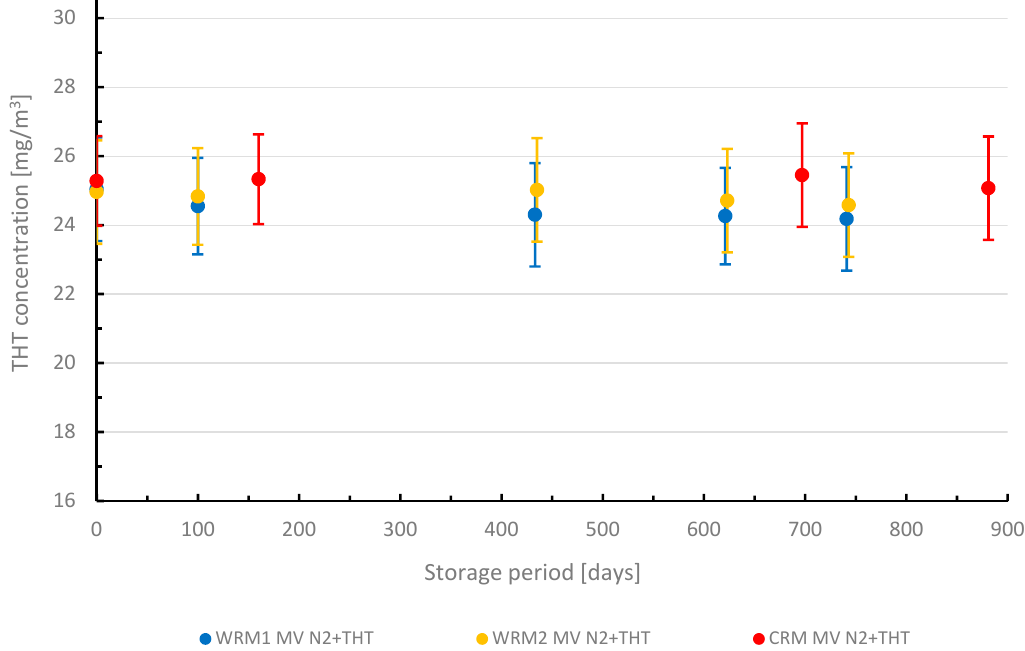
Figure 7. Results of testing the stability of THT concentration in gaseous mixtures of N 2 + THT (T = 20 °C and P = 101.325 kPa).